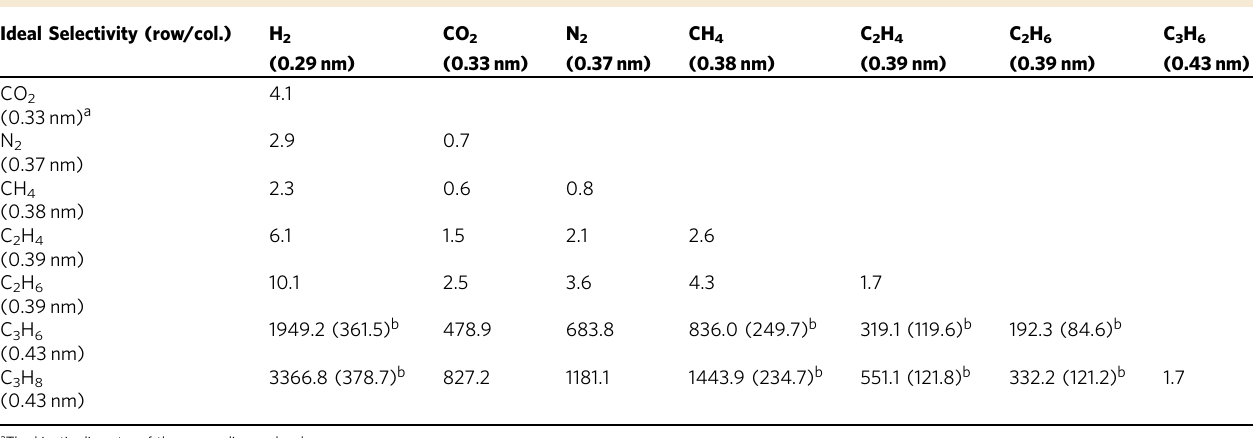
Table 1 The ideal selectivity and separation factors of small gas molecules and light hydrocarbons over the ED-GO@PSSHF membrane ( Δ P = 2 bar, room temperature) Ideal Selectivity